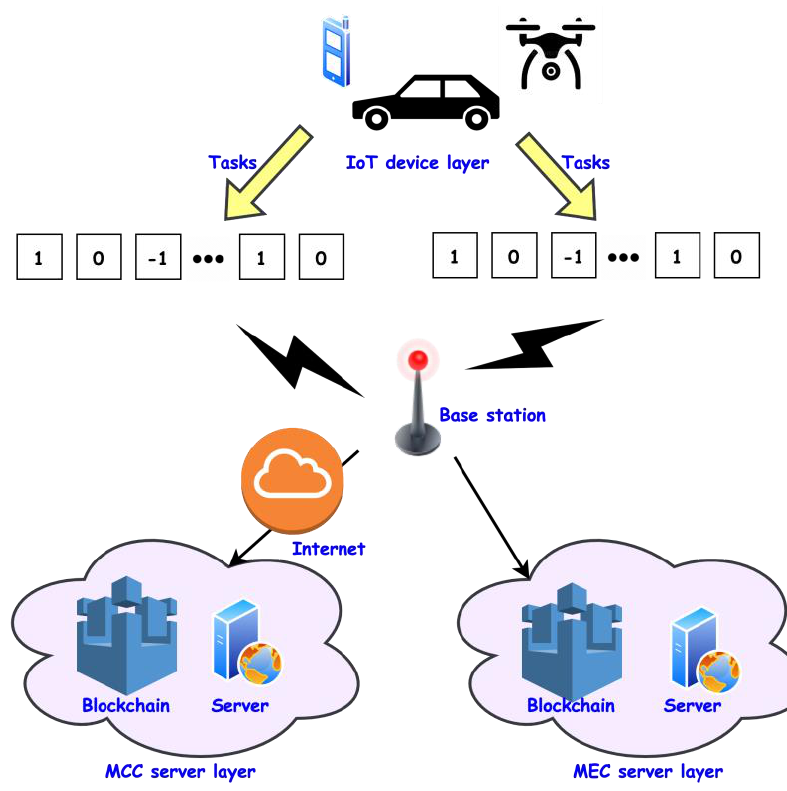
Figure 1. Systematic view of the IoT-SCOM.